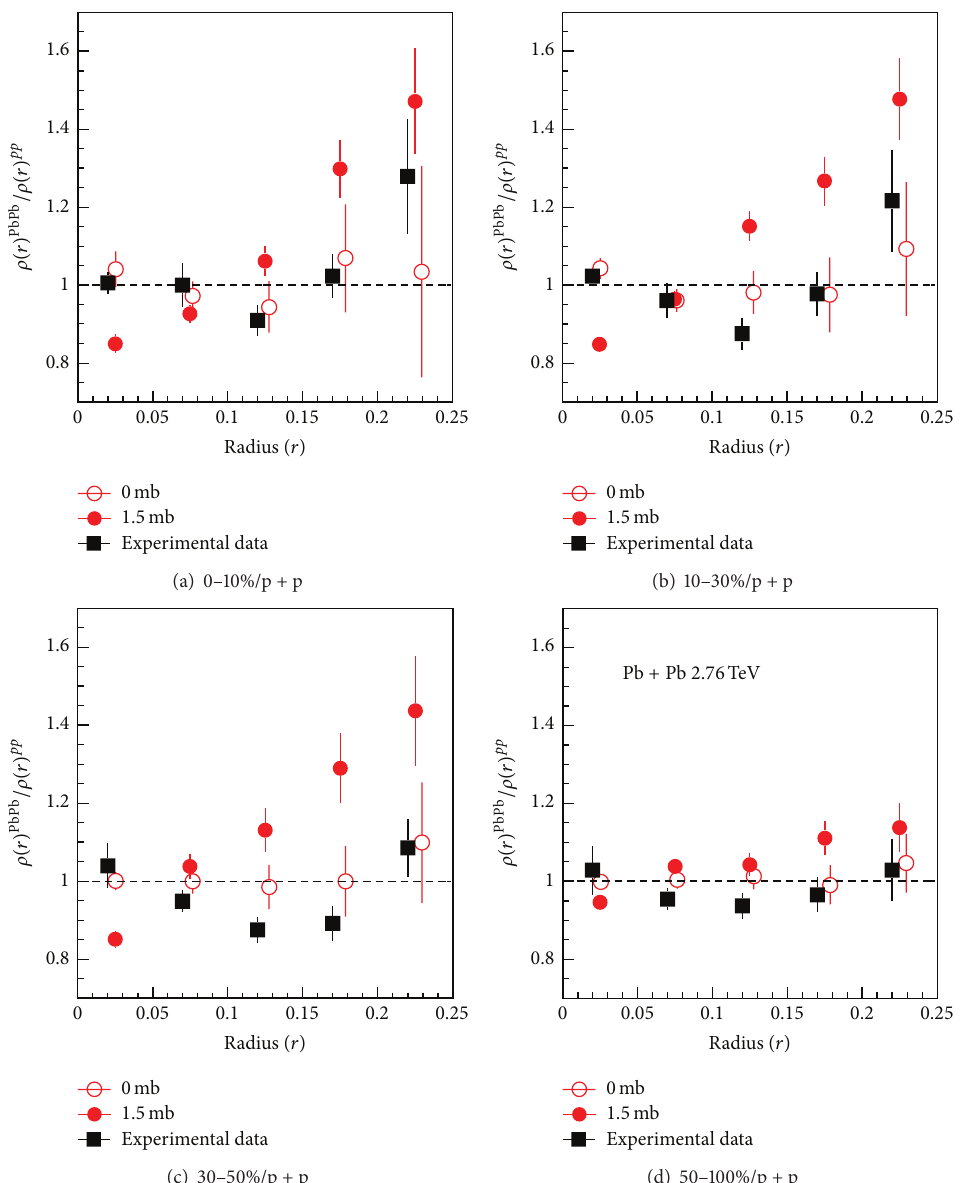
Figure 9: The differential jet shape ratios of four centrality bins in Pb + Pb collisions to p + p collisions, where solid circles represent the AMPT results with partonic + hadronic interactions (1.5mb), open circles represent the AMPT results with hadronic interactions only (0mb), and solid squares represent the data from the CMS experiment [14]. Some points are slightly shifted along the 𝑥 -axis for better